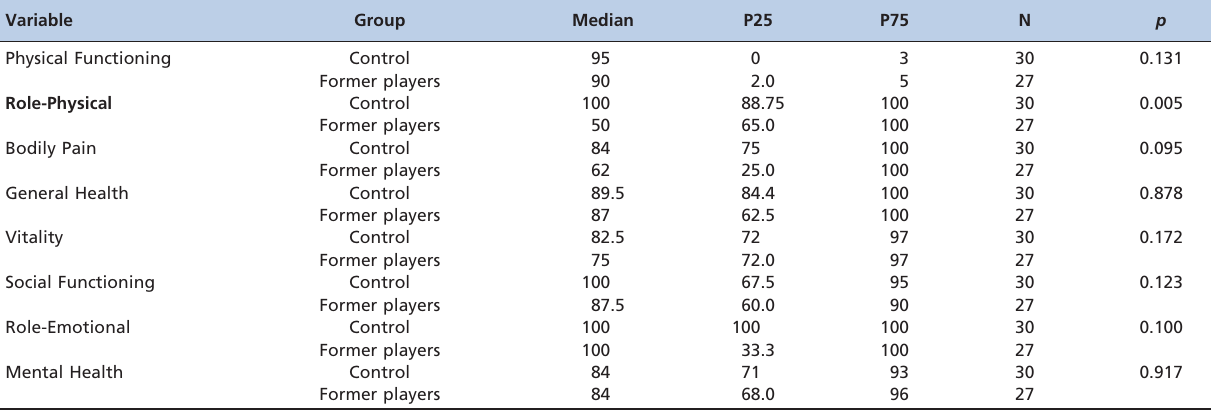
Table 4 - SF-36 subscales comparison between groups.